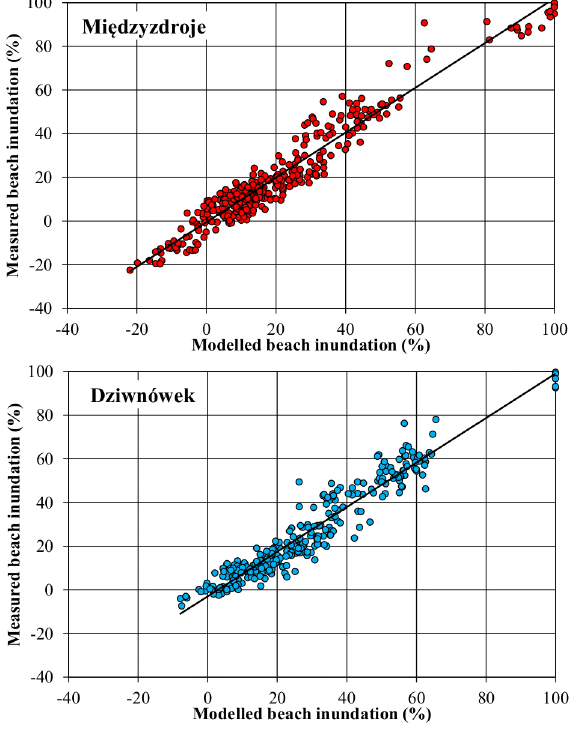
Figure 5. Measured and modelled beach inundation for Mie˛dzyzdroje and